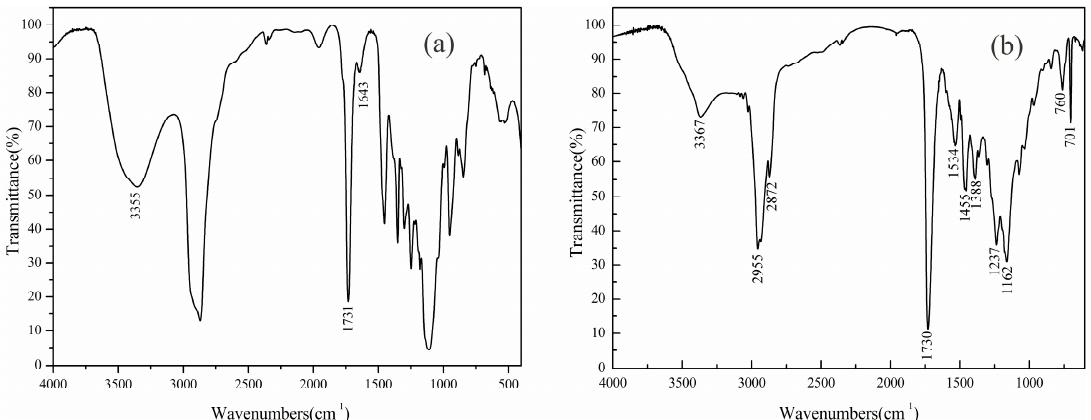
Figure 7. FTIR spectra of ( a ) PET and ( b ) PET-AC emulsion.